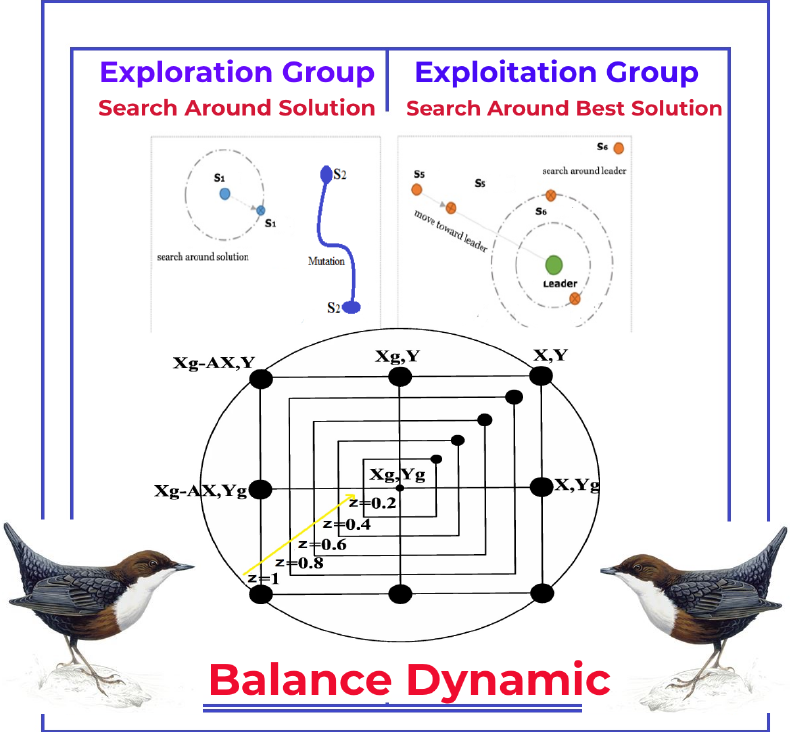
Figure 5. The balance dynamic between exploration and exploitation groups in the proposed opti- mization